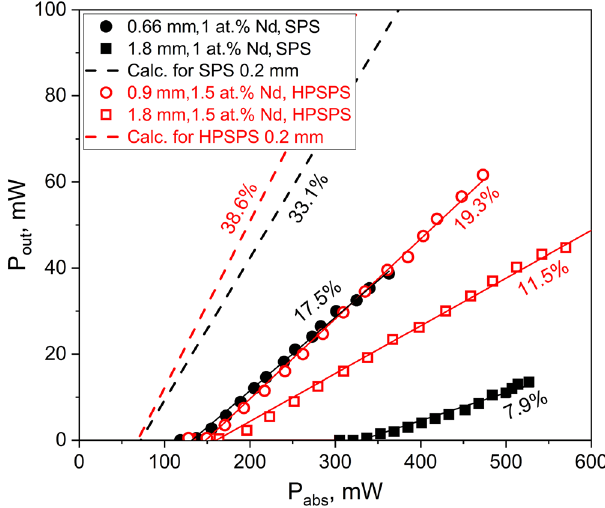
Figure 8. Theoretical estimation of laser output power versus absorbed power, showing the effect of ceramics length on the efficiency of 1 at% Nd SPS-processed Nd:YAG and 1.5 at% Nd HPSPS-processed